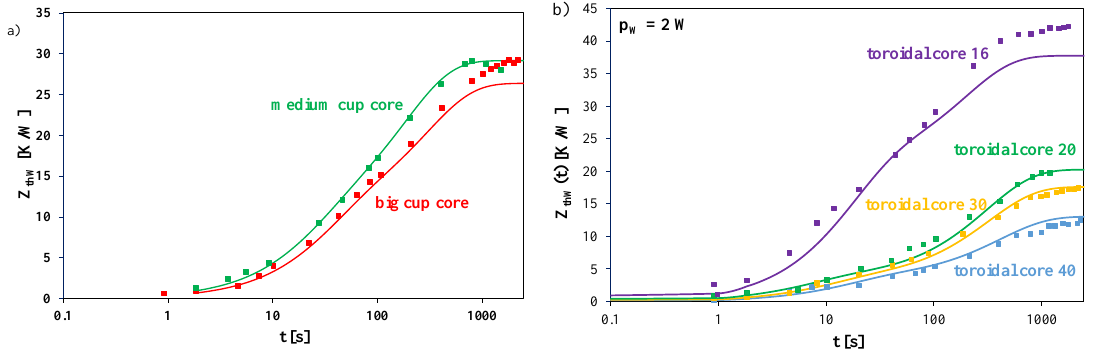
Figure 7. Measured and calculated waveforms of transient thermal impedance of the winding for inductors with ( a ) cup and ( b ) toroidal cores.